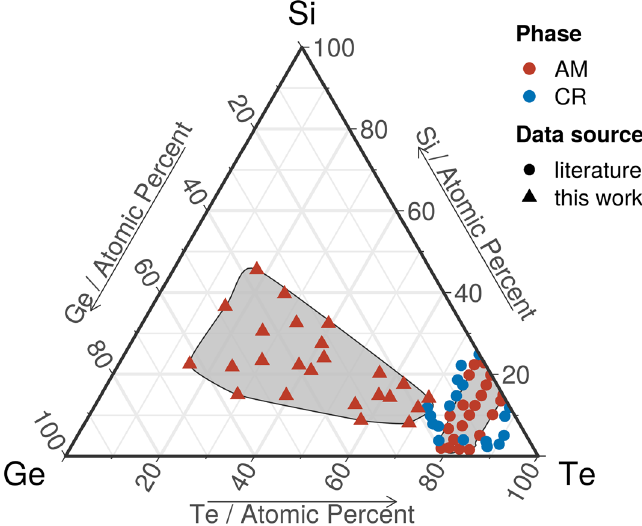
Figure 2. Si–Ge–Te ternary diagram. The structure of the as-deposited Si–Ge–Te library and the GFD from Ref. 28 . Amorphous (AM) compositions are shown in red color and crystalline (CR) samples are depicted in blue. Generated with the R software [v. 3.6.3] (R: A language and environment for statistical computing, R Core Team, R Foundation for Statistical Computing, Vienna, Austria (2020) http:// www.R- proje ct. org/.) using the package ggtern [v. 3.3.0] (https:// cran.r- proje ct. org/ web/ packa ges/ ggtern/ index.